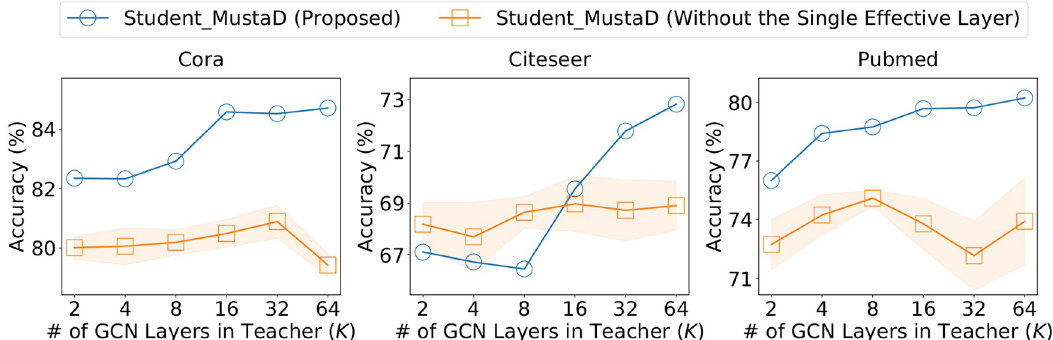
Fig 5. Accuracy of MustaD without the single effective layer. Note that the student without the single effective layer shows significantly lower performance than the original M USTA D.